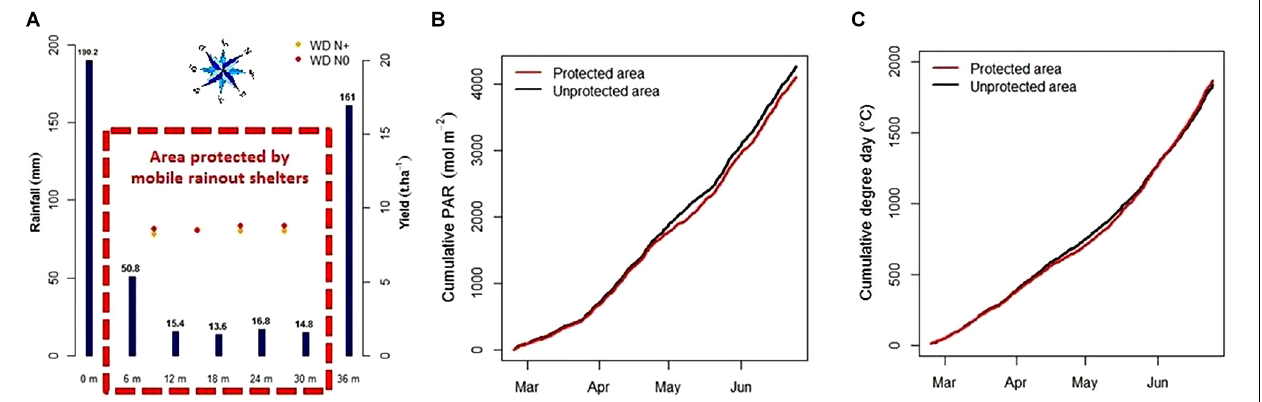
FIGURE 4 | Precipitation levels (mm, blue bars) and yield mean (t/ha, red dots for N+ environment and yellow dots for N0) of the 4 plot-lines using their location from the beginning of the protected area (m, red dotted lines) in water-deficit condition (A) , cumulative daily PAR (B) , and cumulative degree days (C) during the crop protection from rain (from 02/23/2017 to